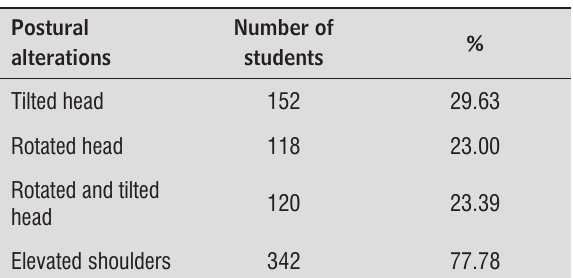
Table 1 - Prevalence of alterations in the positioning of the head and shoulder in the anterior